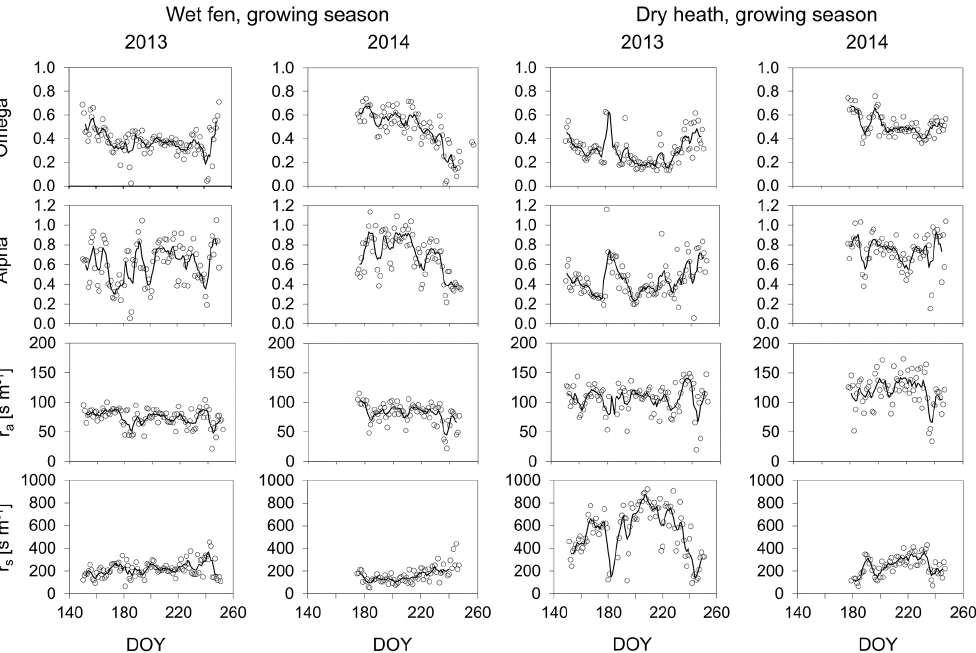
Figure 9. Omega, alpha, aerodynamic resistance and surface resistance. Mean daily (empty circles) and 5-day running mean (solid line) of McNaughton and Jarvis decoupling factor (omega), Priestley and Taylor alpha value (alpha), aerodynamic resistance ( r a ) and surface resistance ( r s ) at the wet fen (left panels) and dry heath (right panels) during the growing seasons in 2013 and